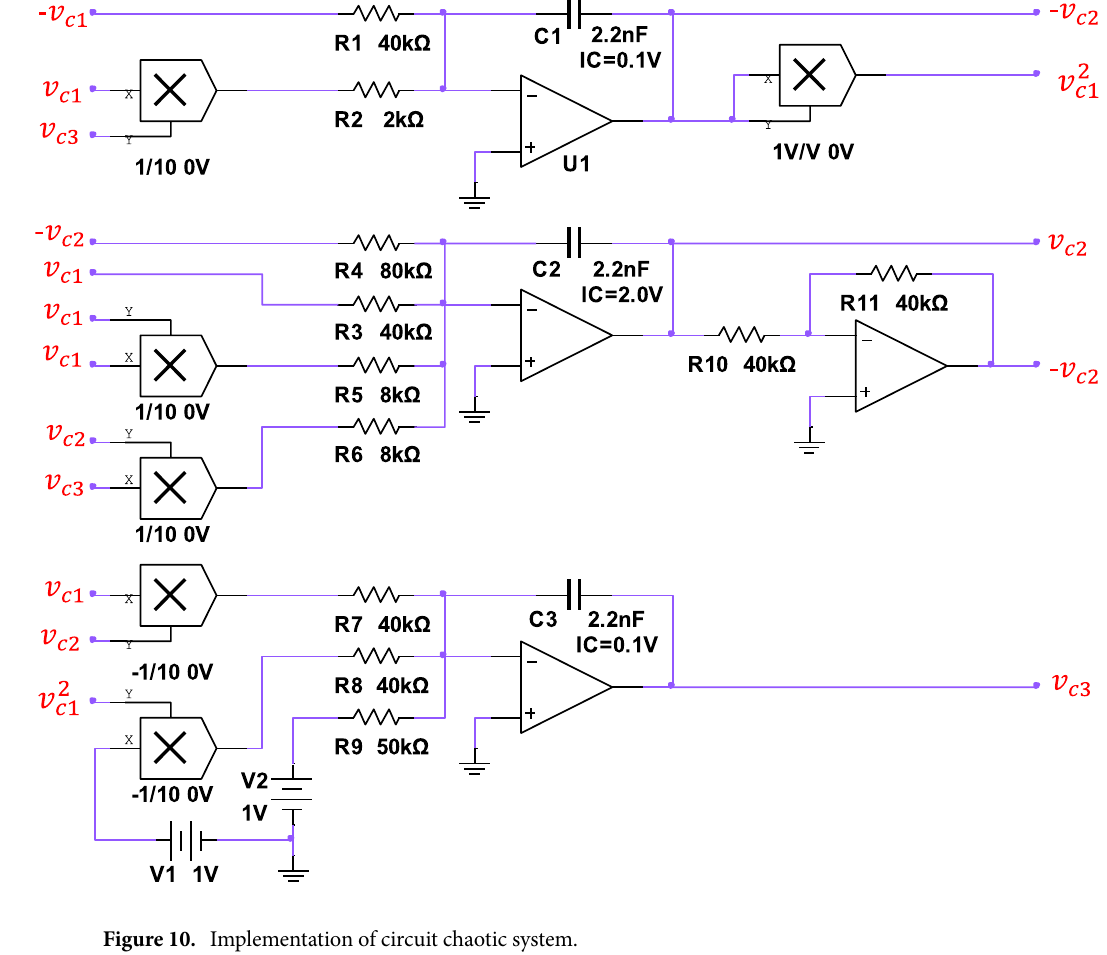
Figure 10. Implementation of circuit chaotic system.